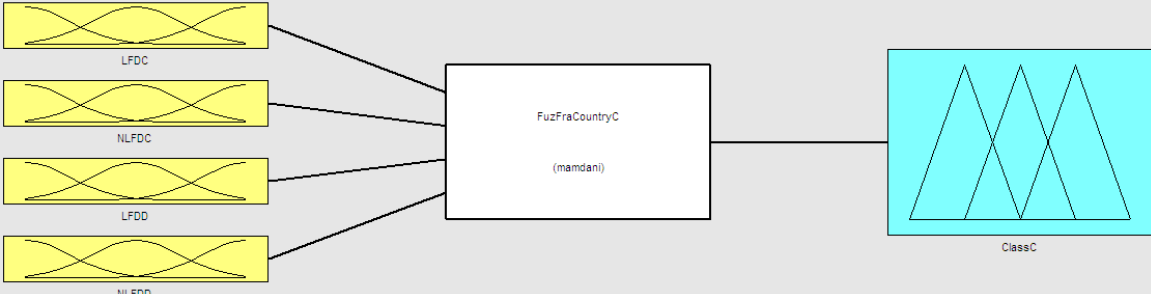
Figure 3. Architecture of the model for Country Classification based on COVID-19 data.